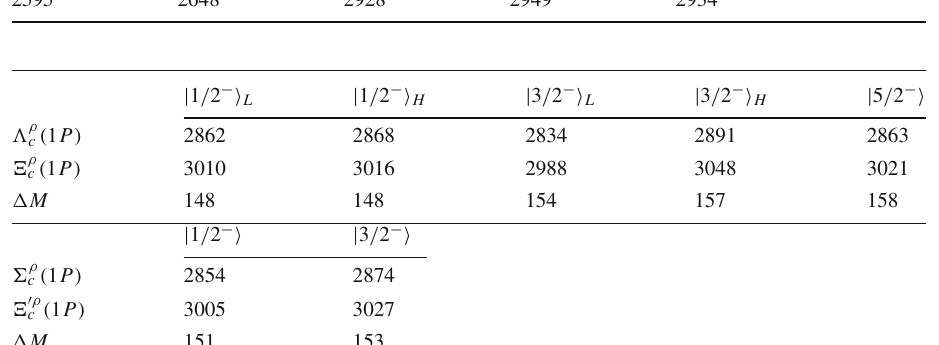
Table 6 A comparison of the predicted masses of established charm baryons with the measured results (in MeV). The measured masses are listed in the first row below the states while the predictions are given in the second row. The measured masses of (cid:3) (cid:3) c ( 2923 ) , (cid:3) (cid:3) c ( 2939 ) , and (cid:3) (cid:3) c ( 2965 ) are taken from Ref. [48], while the others are borrowed from Ref. [60]